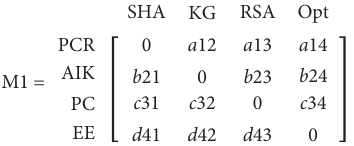
Figure 2: Logical diagram.